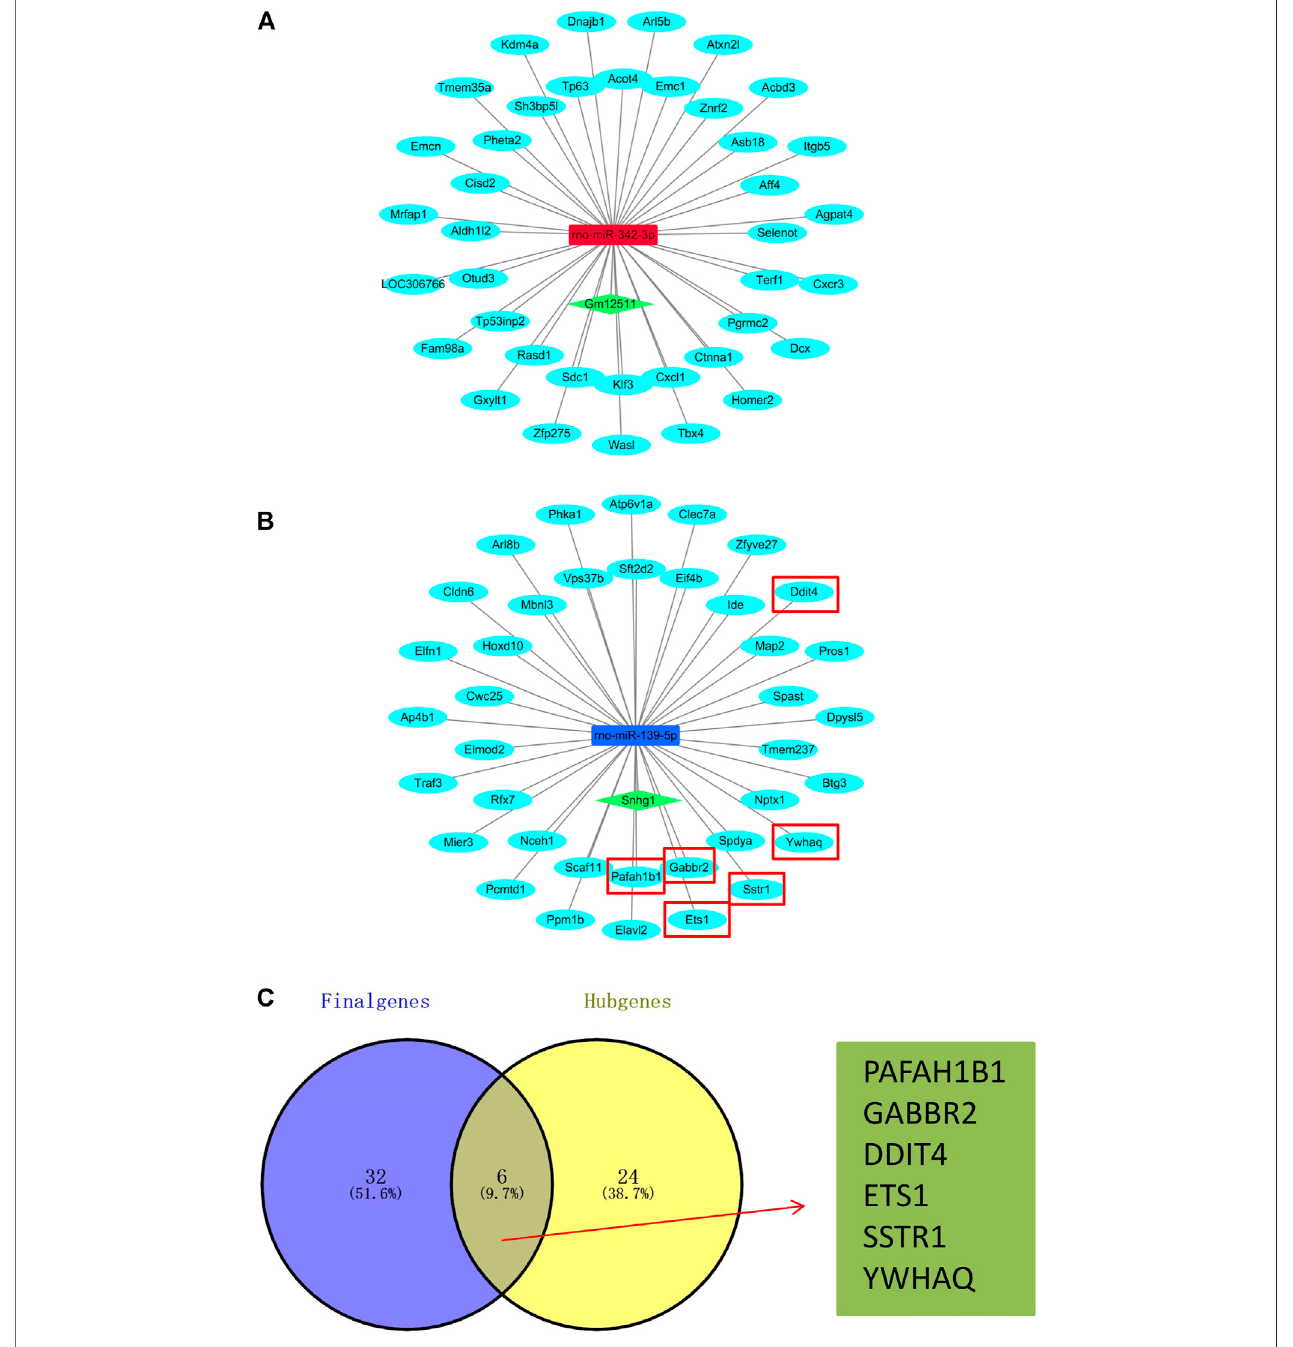
FIGURE 5 | Construction of the ceRNA network. (A,B) ceRNA network of the acute rejection model after liver transplantation in rats. Skyblue nodes: mRNAs. Red nodes: upregulated miRNAs. Blue nodes: downregulated miRNAs. Green nodes: lncRNAs. (C) Venn diagram of the overlap for target genes (Final genes) regulated by rno-miR-139-5p and 30 hub genes (Hub